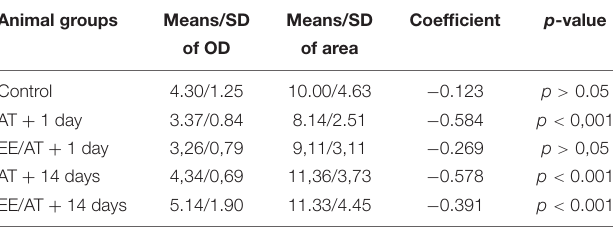
TABLE 1 | Correlation